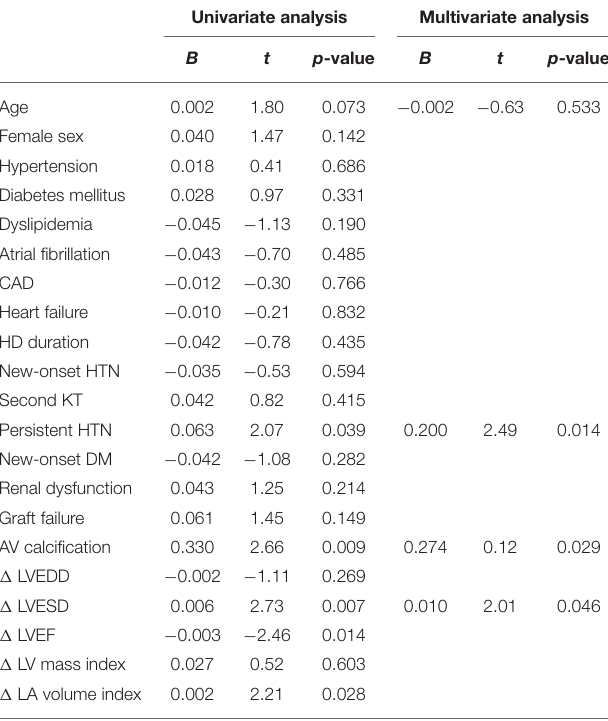
TABLE 6 | Factors associated with progression of aortic regurgitation after